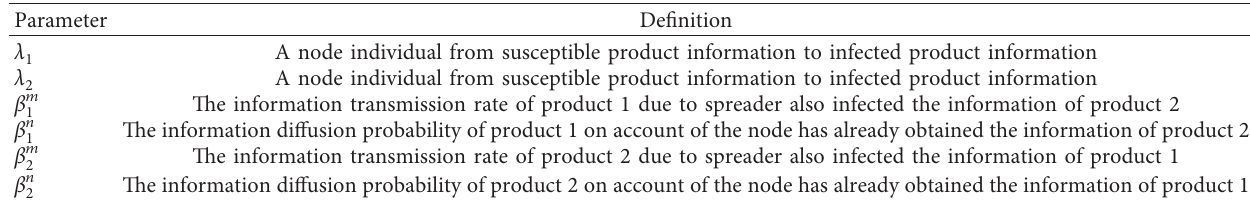
Table 1: Definition of model